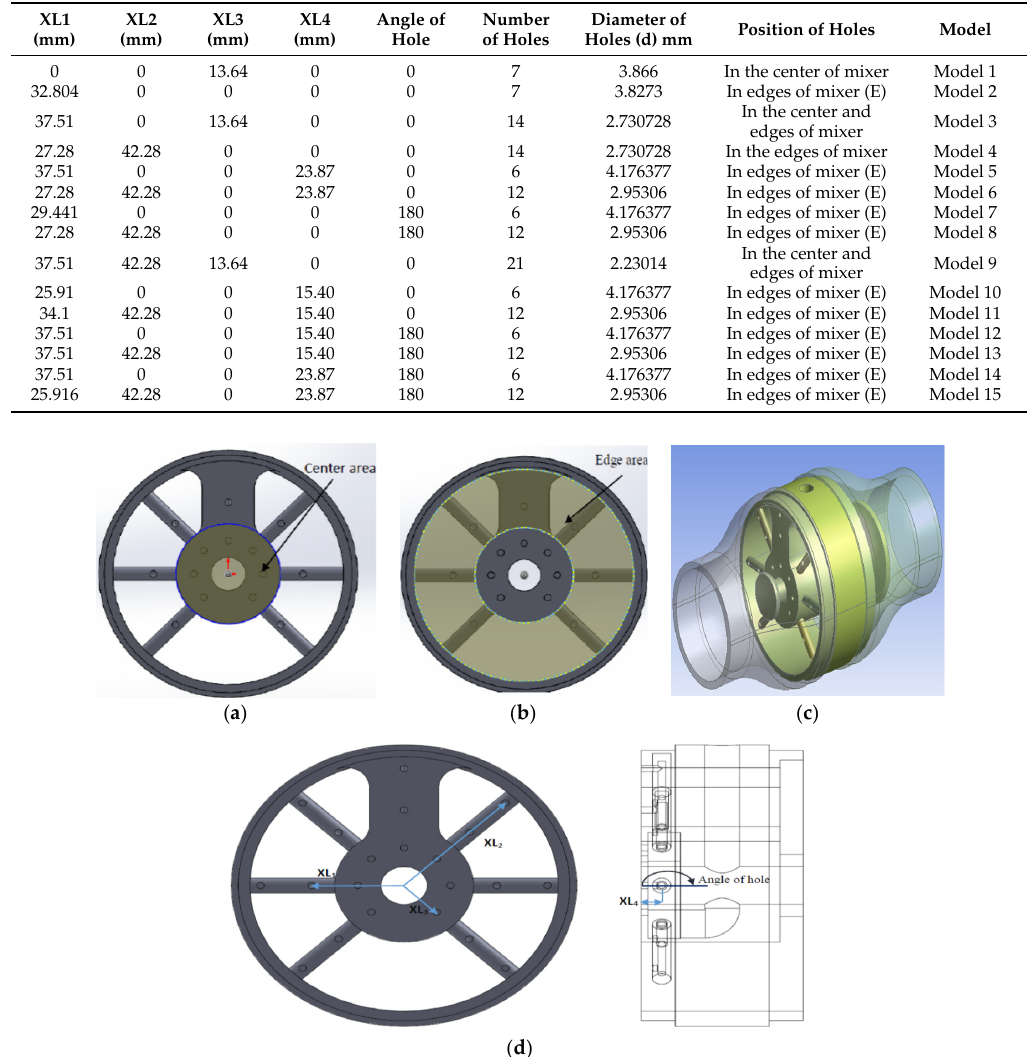
Table 1. The models and cases that used to study the homogeneity and distribution of the mixture inside the mixer.